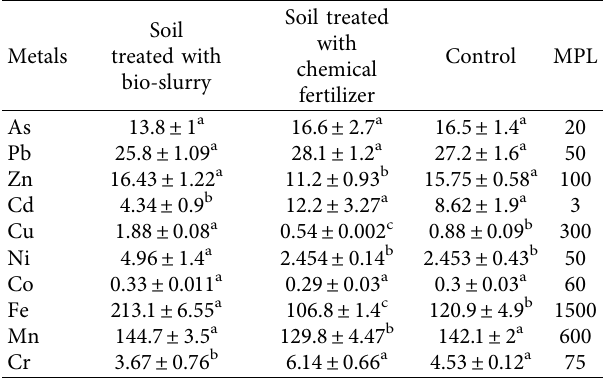
Table 5: Efects of bio-slurry and chemical fertilizer application on the physico-chemical properties of the soils. Treatment